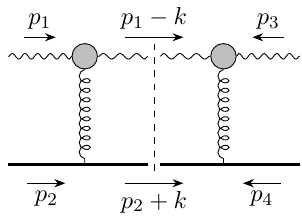
Figure 2 . Pictorial representation of the r.h.s. of eq. (4.9). In this picture, the grey blobs represent effective vertices of order α . Recall that with in-coming momenta p µ